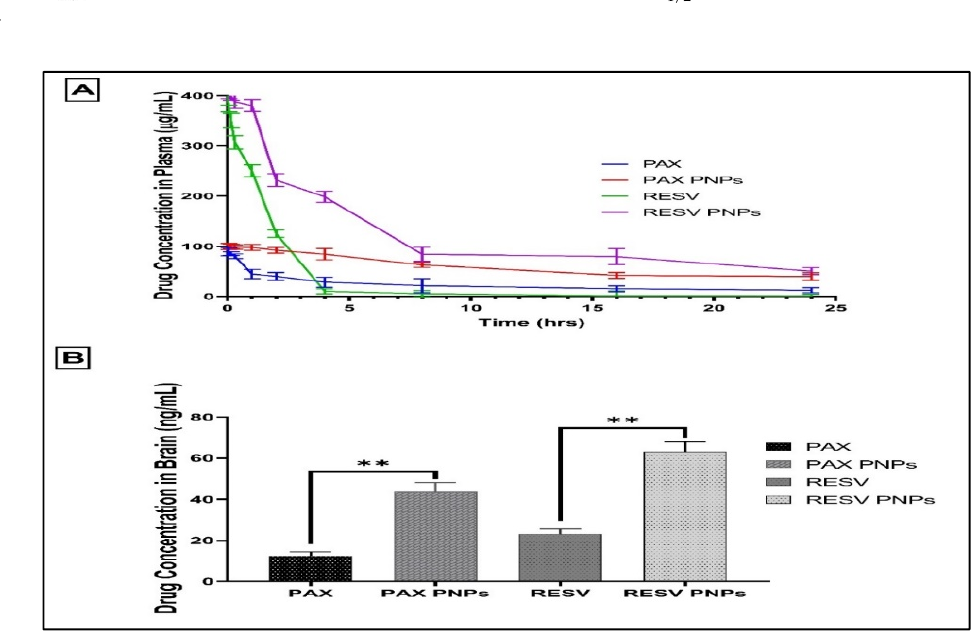
Figure 8. In vivo pharmacokinetics and brain distribution of PAX-RESV loaded PNPs or free PAX and RESV. ( A ) The In vivo pharmacokinetics results of PAX-RESV loaded PNPs or free PAX and RESV concentration in Plasma. ( B ) The In vivo brain distribution results of PAX-RESV loaded PNPs or free PAX and RESV concentration in Brian. ** indicates p < 0.01 results are statistically significant. Data represent the mean± standard deviation ( n = 3).